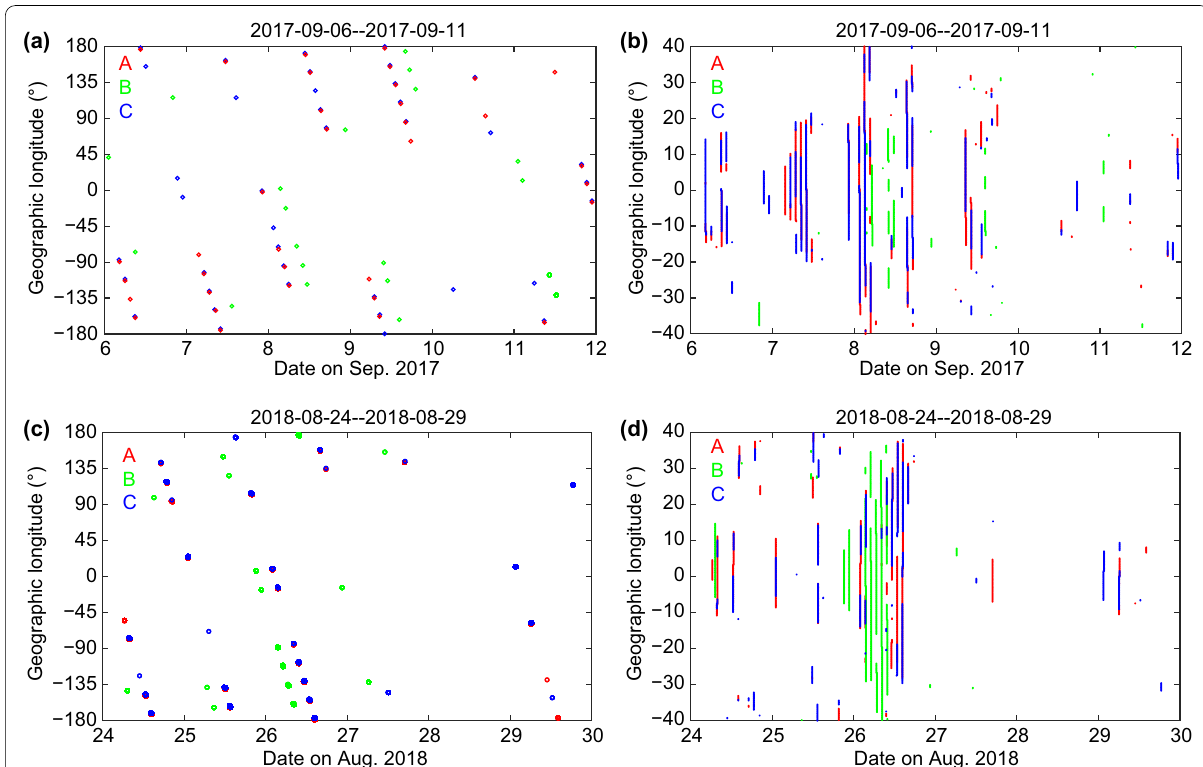
Fig. 4 ( a and c ) The geographic longitude versus UTC and ( b and d ) MLAT versus UTC distributions of small-scale plasma irregularities observed by the Swarm satellites during geomagnetic storms on ( a and b ) 6–11 September 2017 and ( c and d ) 24–29 August 2018. The results from Swarm A, B, and C are marked with red, green, and blue colors. For the left side panels, each circle represents one equatorial orbital segment of Swarm with small-scale (less than 300 km) plasma irregularities